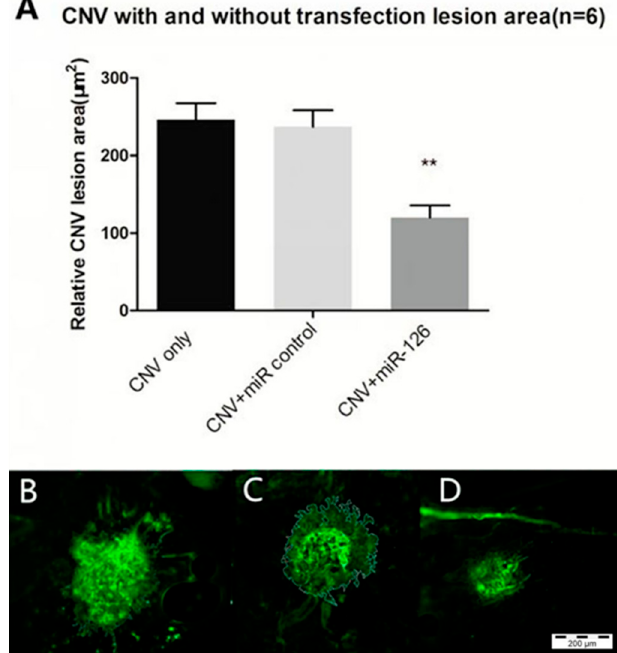
Figure 9. Representative micrographs of the CNV lesions from choroidal flatmount in three groups: ( A ) Quantification of relative 2D lesion areas in the eyes of CNV mice after laser treatment in choroidal flatmount. Lesion areas were measured using the ImageJ software. Data are expressed as relative CNV lesion area ± SD, n = 6, ** p < 0.01; ( B – D ) Representative micrographs of CNV lesions of Isolectin GS-IB4 *AF488 stained choroidal flatmount, with manual border delineation in the ImageJ: ( B ) CNV-only (CNV mice without treatment); ( C ) CNV+ miR-control (CNV mice transfected with negative control); and ( D ) CNV+ miR-126 (CNV mice transfected with miR-126 mimic ); Scale bar = 200 μ m.